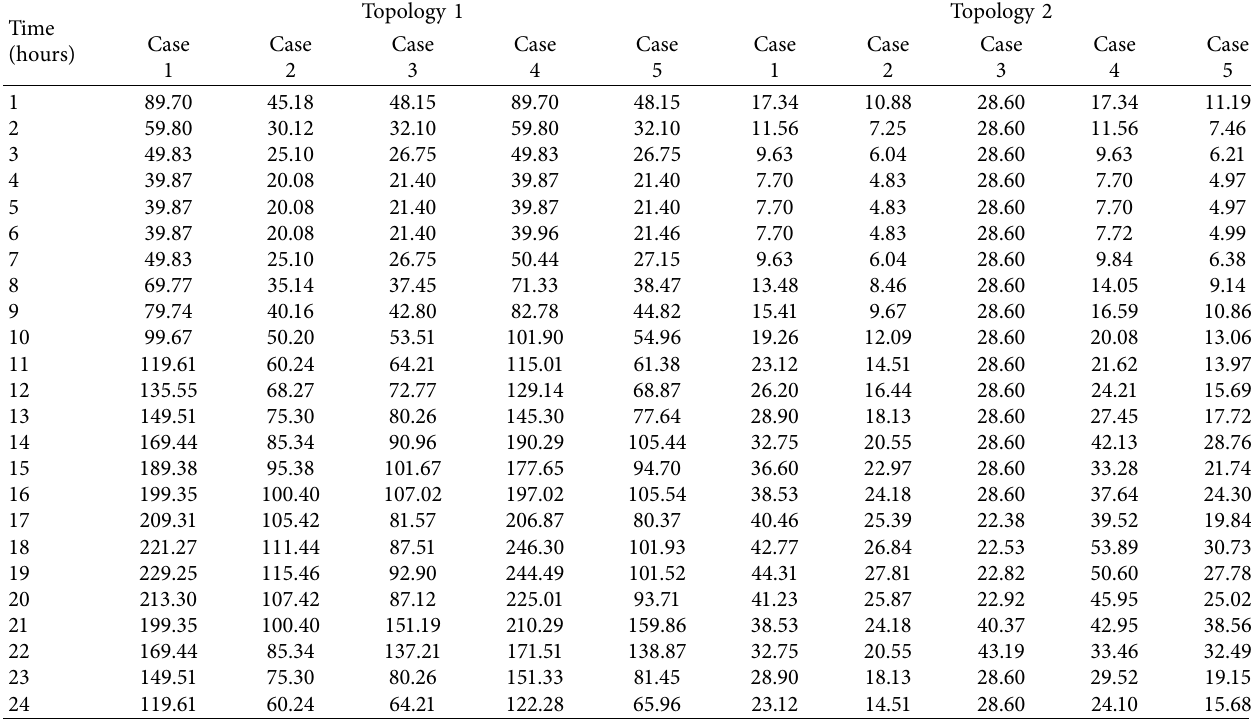
Table 9: Power loss (in kW) 69 bus system scenario 2.